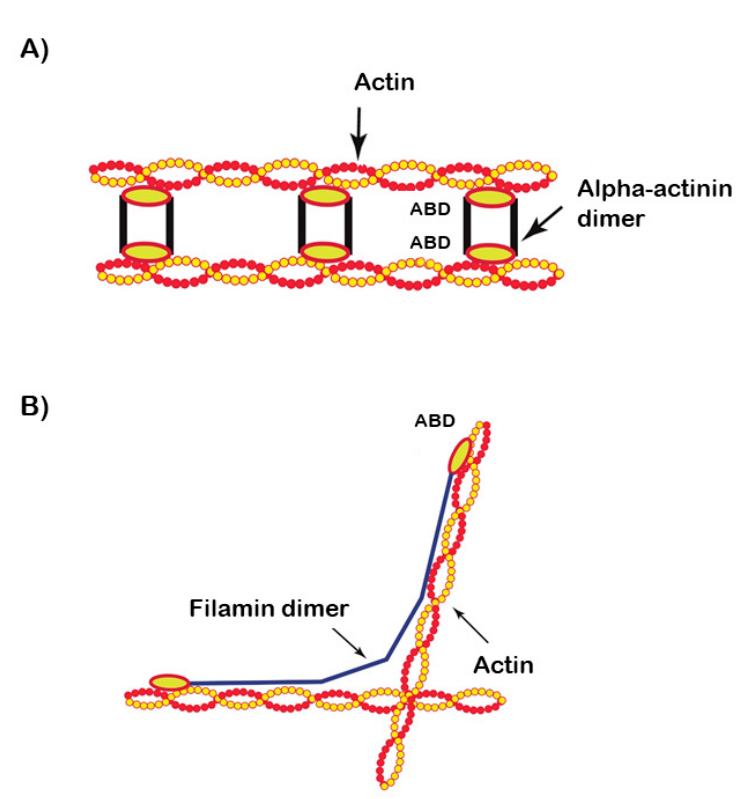
Figure 2. Schematic representation comparing the different microstructure and crosslinking properties of alpha-actinin ( A ) and filamin ( B ). Actin-binding domains (ABD) of both proteins are highlighted.